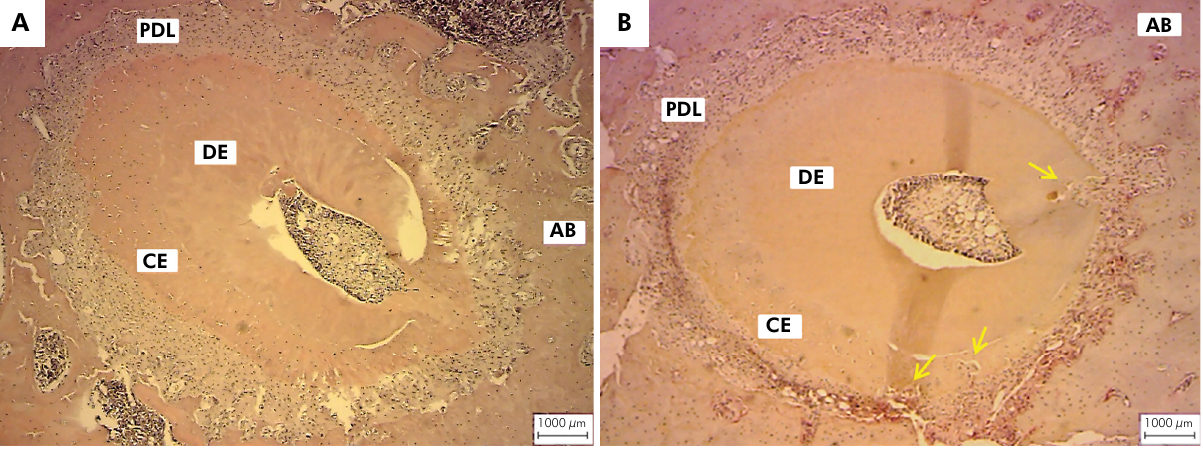
AB: alveolar bone; PDL: periodontal ligament; CE: cement. The yellow arrows indicate osteoclasts. (TRAP, 400x). Figure 4. Photomicrographs of the SM (A) and FM (B) groups on the 7 th day of orthodontic tooth